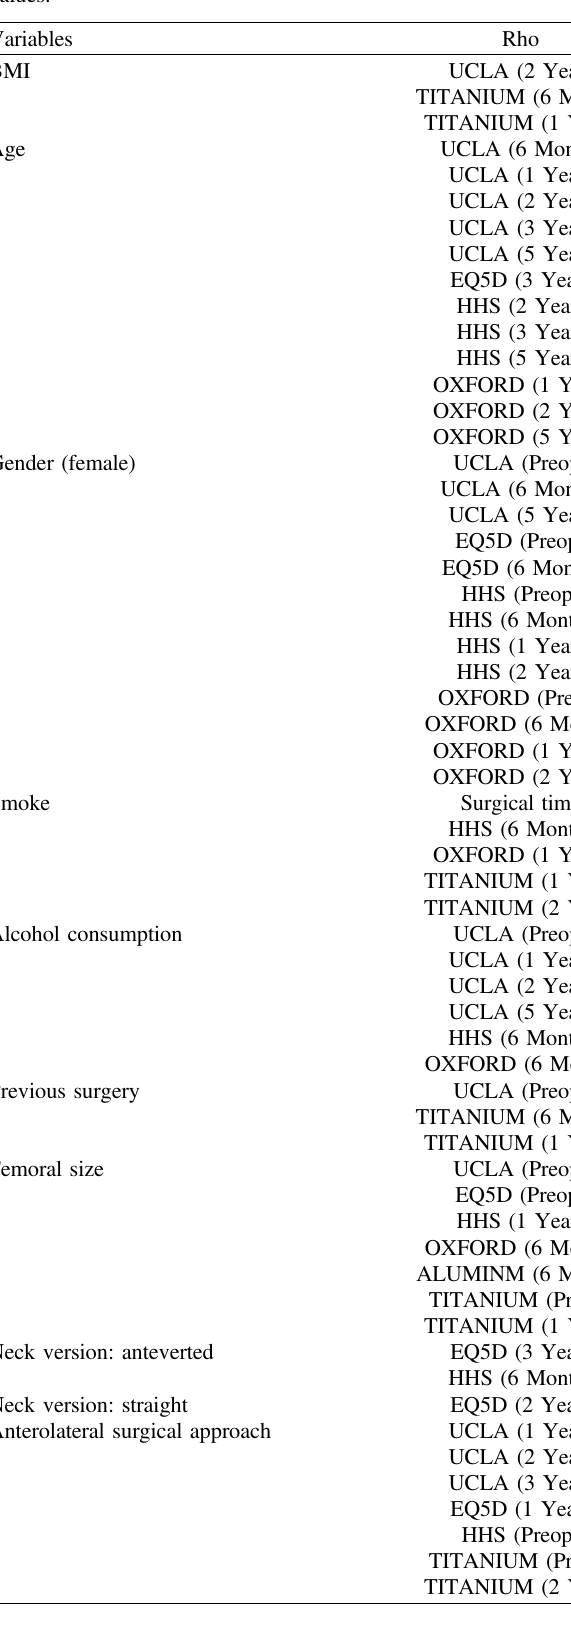
Table A.12. Signi fi cant correlation between sociodemographic and surgical characteristics and surgical time, clinical scores and laboratory